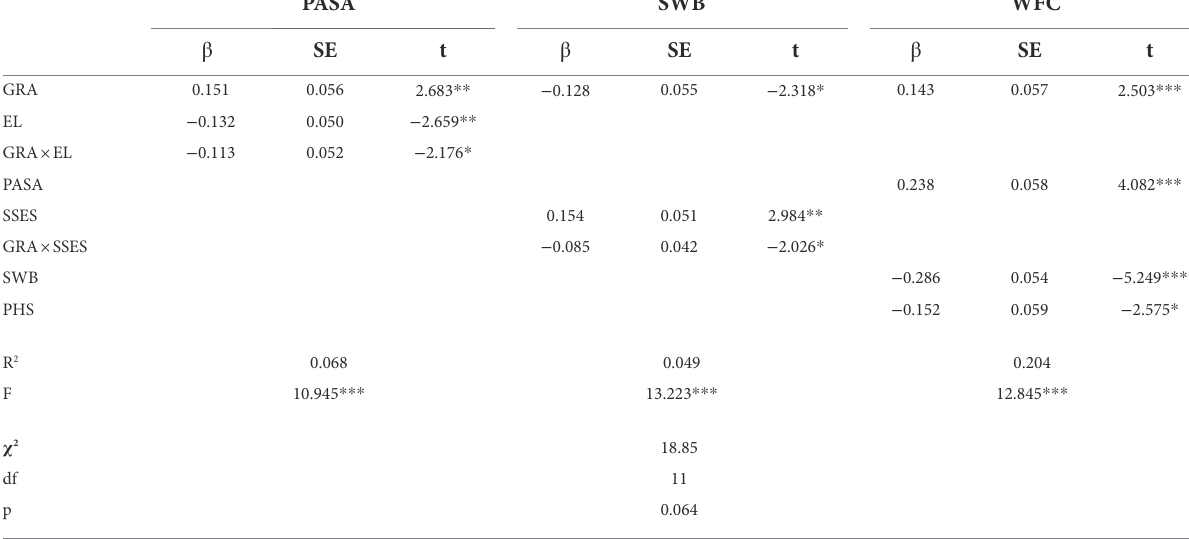
TABLE 2 Results of conditional process